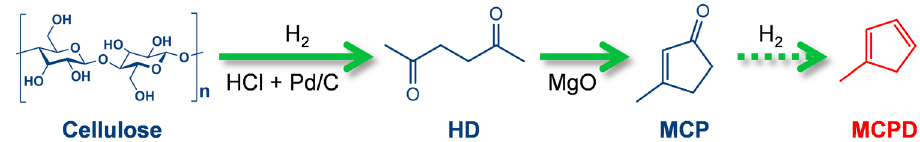
Fig. 1 Strategy for MCPD production from cellulose. By the selective hydrodeoxygenation of the MCP which can be obtained from the HCl + Pd/C catalyzed cellulose hydrogenolysis followed by the MgO catalyzed intramolecular aldol condensation, a high yield of MCPD was achieved in this